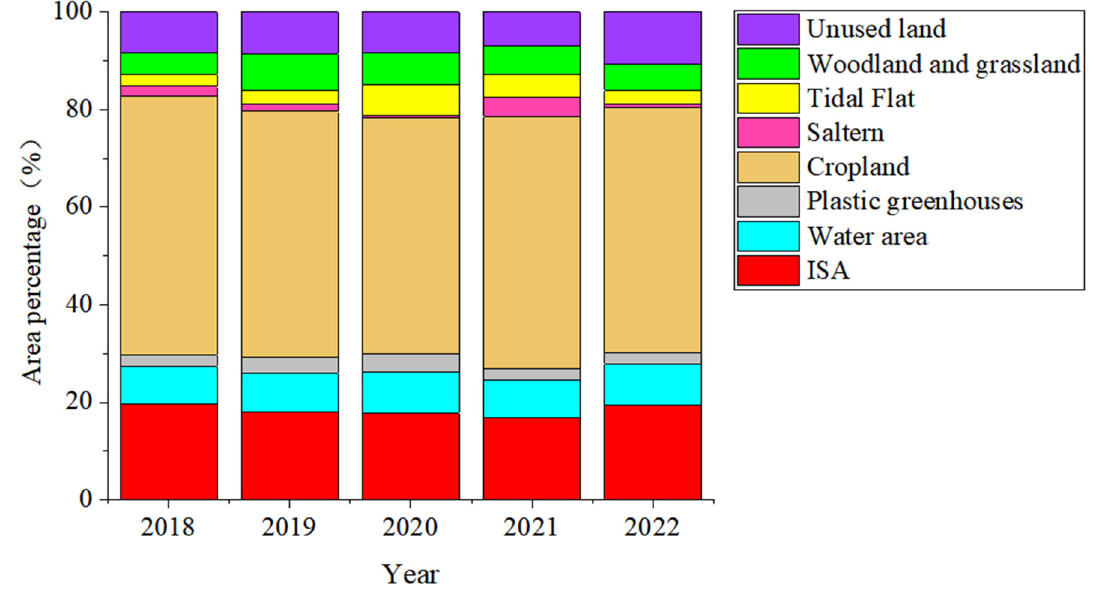
Figure 10. Annual area comparison of different LULC types.